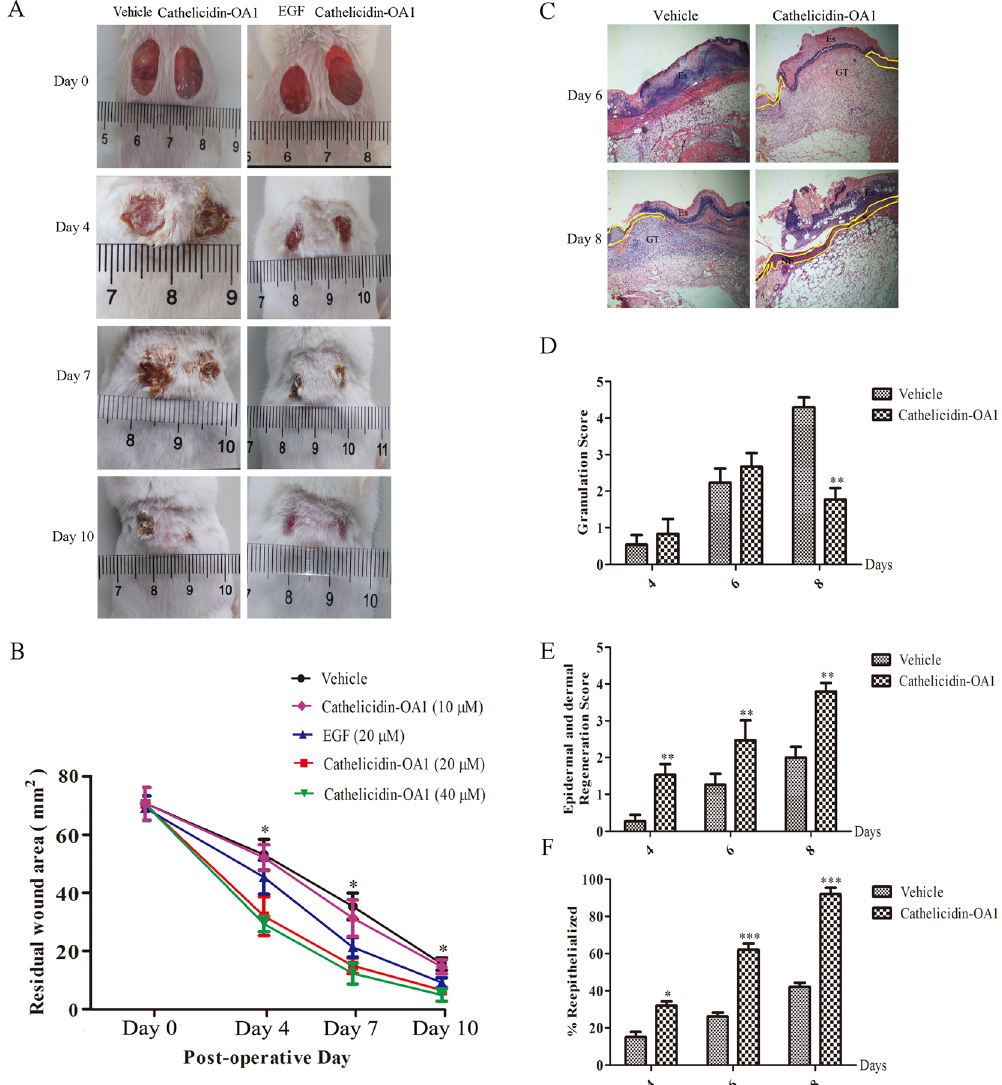
Figure 7. Topical application of cathelicidin-OA1 accelerated healing of full- thickness skin wounds in mice. ( A ) Macroscopic view of wound healing on days 0, 4, 7, and 10. Two 8 × 8 mm wounds were created on the back of each mouse, with wounds treated twice a day with 20 μ l of saline (vehicle), 20 μ M cathelicidin-OA1, or 20 μ M EGF and 20 μ M cathelicidin-OA1, respectively. Images of representative mice were taken on days 0, 4, 7, and 10 post-operation. ( B ) Cathelicidin-OA1 illustrated time- and dose-dependent wound-healing activity in the mouse model. Wound closure was assessed by morphometrical analysis of wound areas (Image J, NIH). Wound residual area was determined (n = 10) from three independent experiments. * P < 0.05 indicates the group treated with cathelicidin-OA1 (20 μ M and 40 μ M) was significantly different from the negative control (Students t- test). ( C ) Histopathological examination of vehicle and cathelicidin-OA1-treated (20 μ M) healing skins (post-operative days 5 and 9) stained with H&E. Neo-epithelium marked by yellow dotted line was much longer at the same magnitude of enlargement in cathelicindin-OA1-treated mice than in vehicle controls (NE: neo-epithelium; GT: granulation tissue; Es: eschar). ( D , E , F ) Epidermal thickness in mice; histological scores of granulation thickness and epidermal and dermal regeneration. All bars represent means ± SD from three independent experiments and six different sections for each experiment. * P < 0.05, ** P < 0.01 and *** P < 0.0001 (cathelicidin-OA1 treatment vs